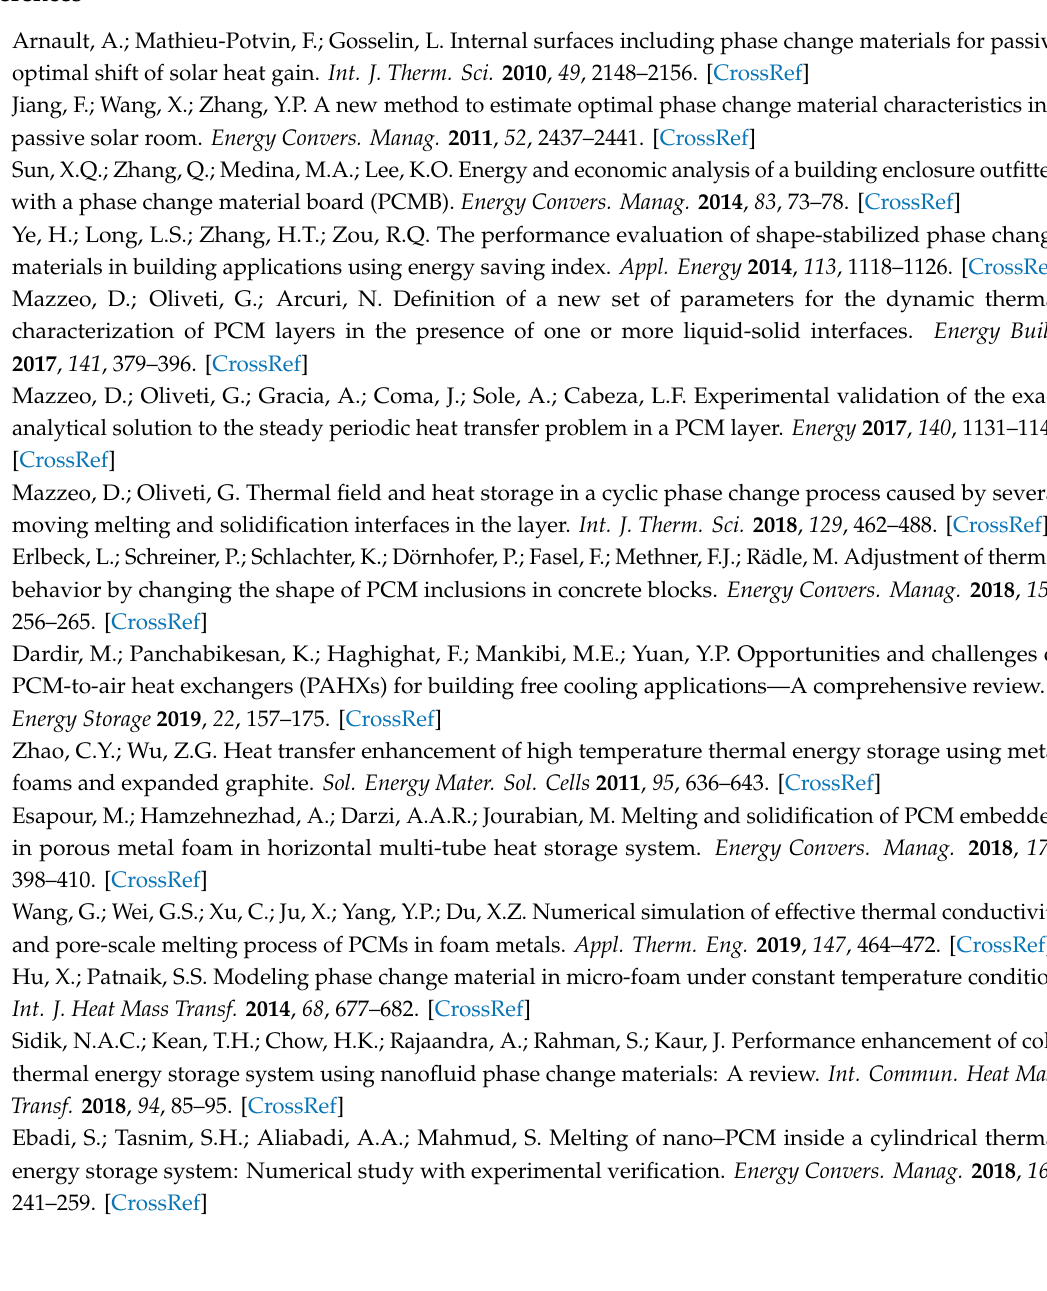
Figure A4. Comparisons of the energy absorption increase between the cells with the smaller aspect ratio ( AR = 0.5) and those with the larger aspect ratio ( AR = 1.0). ( a ) Ra = 3.095 × 10 5 ; ( b ) Ra = 4.83 × 10 6 ; ( c ) Ra = 3.87 × 10 7 .